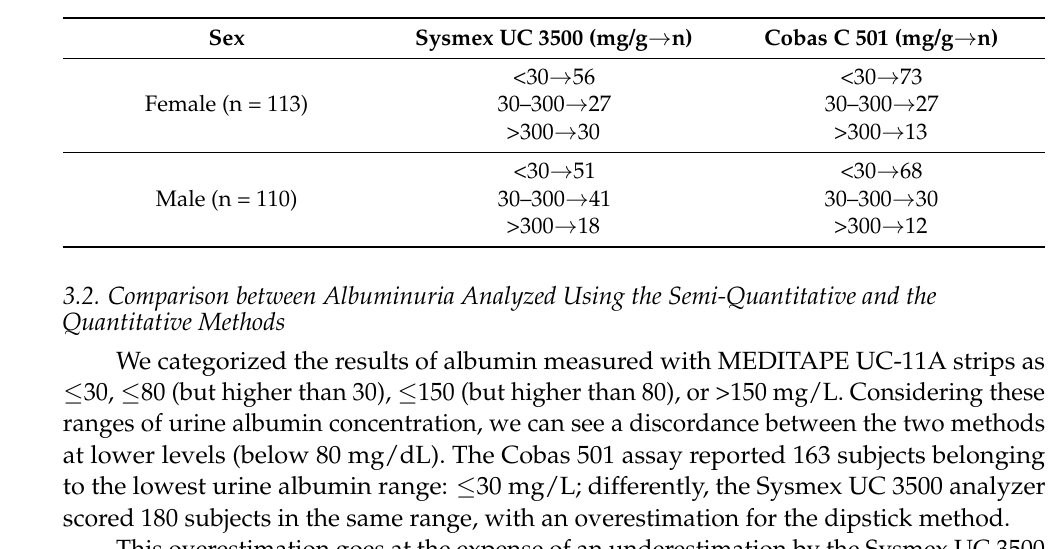
Table 5. Strati fi cation of urinalysis results of albumin/creatinine ratio based on sex. Table 5. Stratification of urinalysis results of albumin/creatinine ratio based on sex.